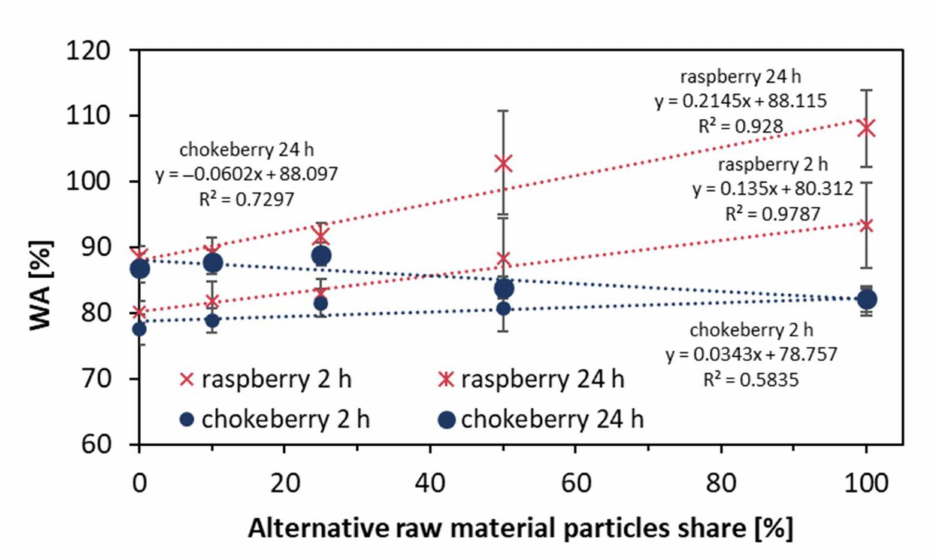
Figure 9. Water absorption of the tested